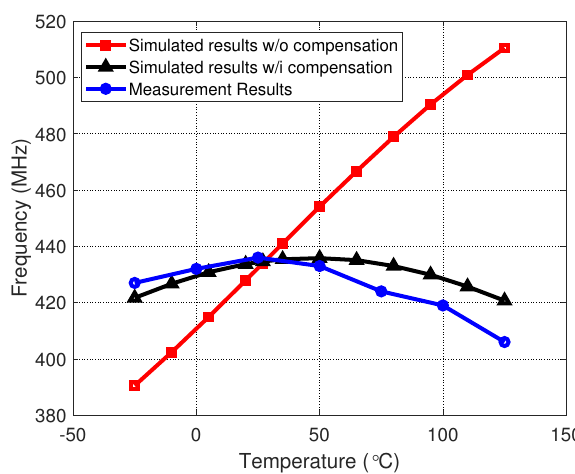
Figure 11. Frequency variations versus temperature with/without compensation.